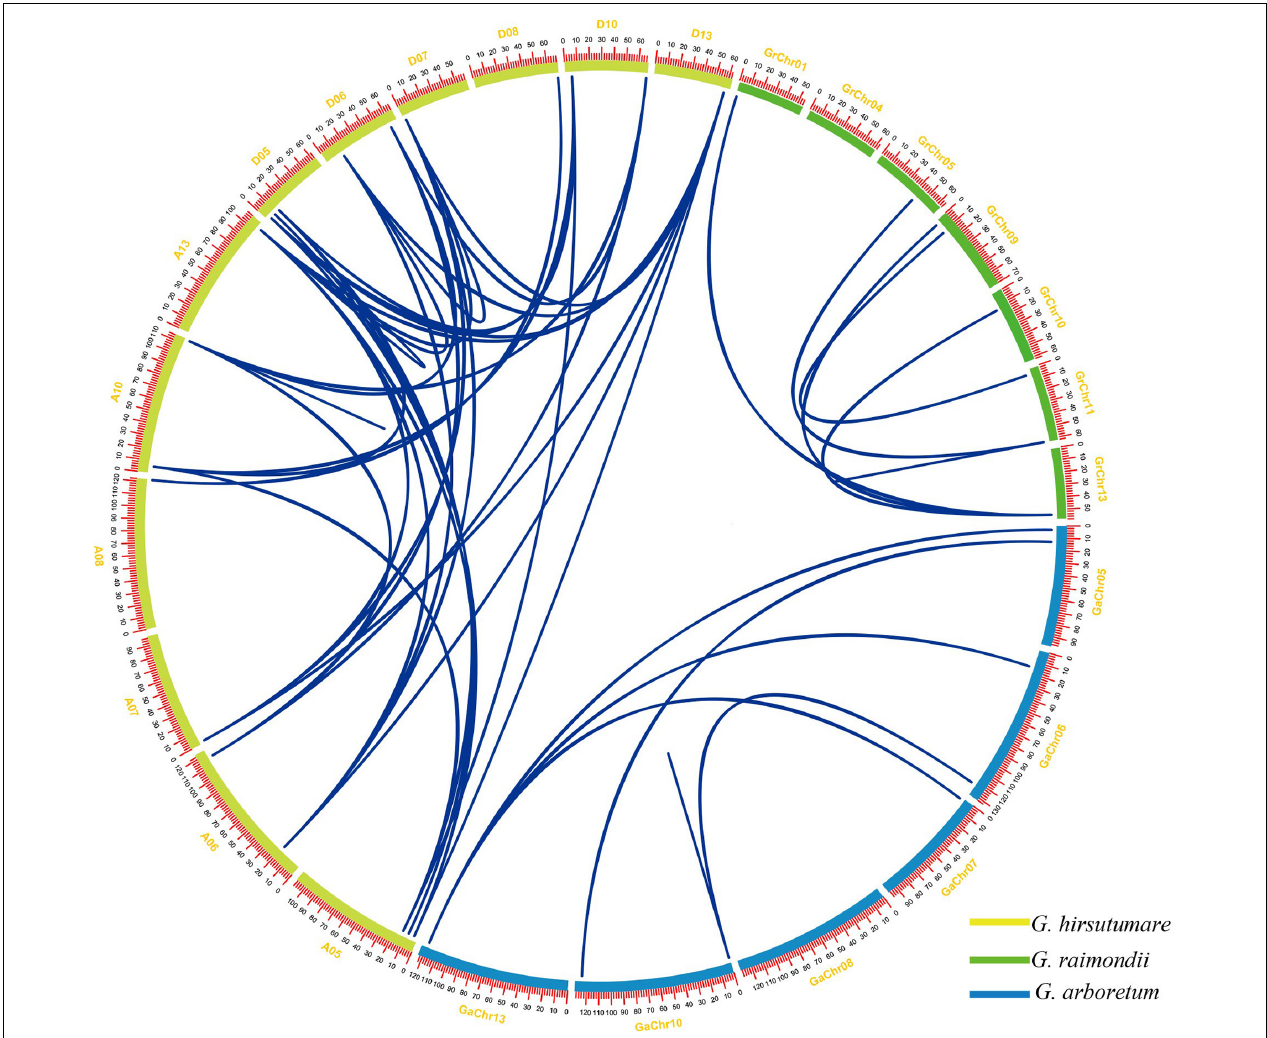
FIGURE 3 | The gene pairs of segment duplication in GrELF4s , GaELF4s, and GhELF4s. The chromosomes of G. raimondii , G. arboretum, and G. hirsutum are filled with green, blue, and yellow, respectively. Gene pairs involved in segment duplication are linked by a line. The scale on the circle is in megabases (Mb).